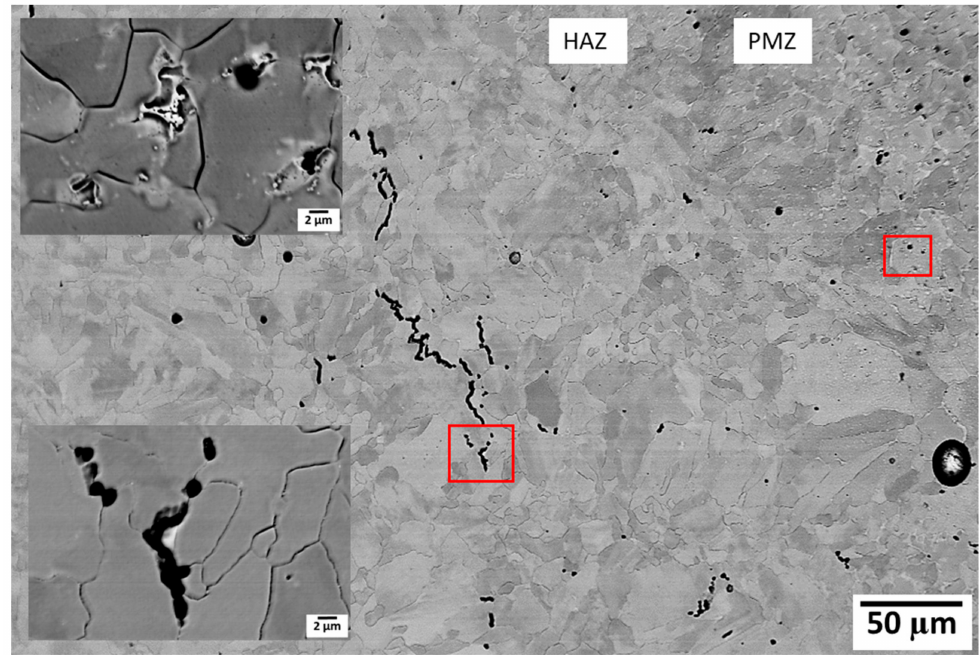
Figure 11. HAZ of welded SHT + AGE material showing microfissure with liquation product in PMZ, and an example of grain boundary cracking without any visible liquation in the HAZ; insets showing the marked areas.